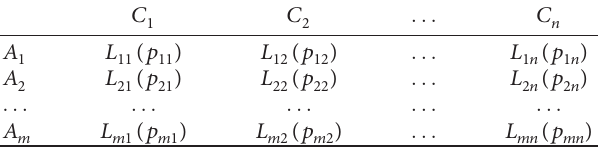
Table 1: Decision matrix of the PL3W-MADM